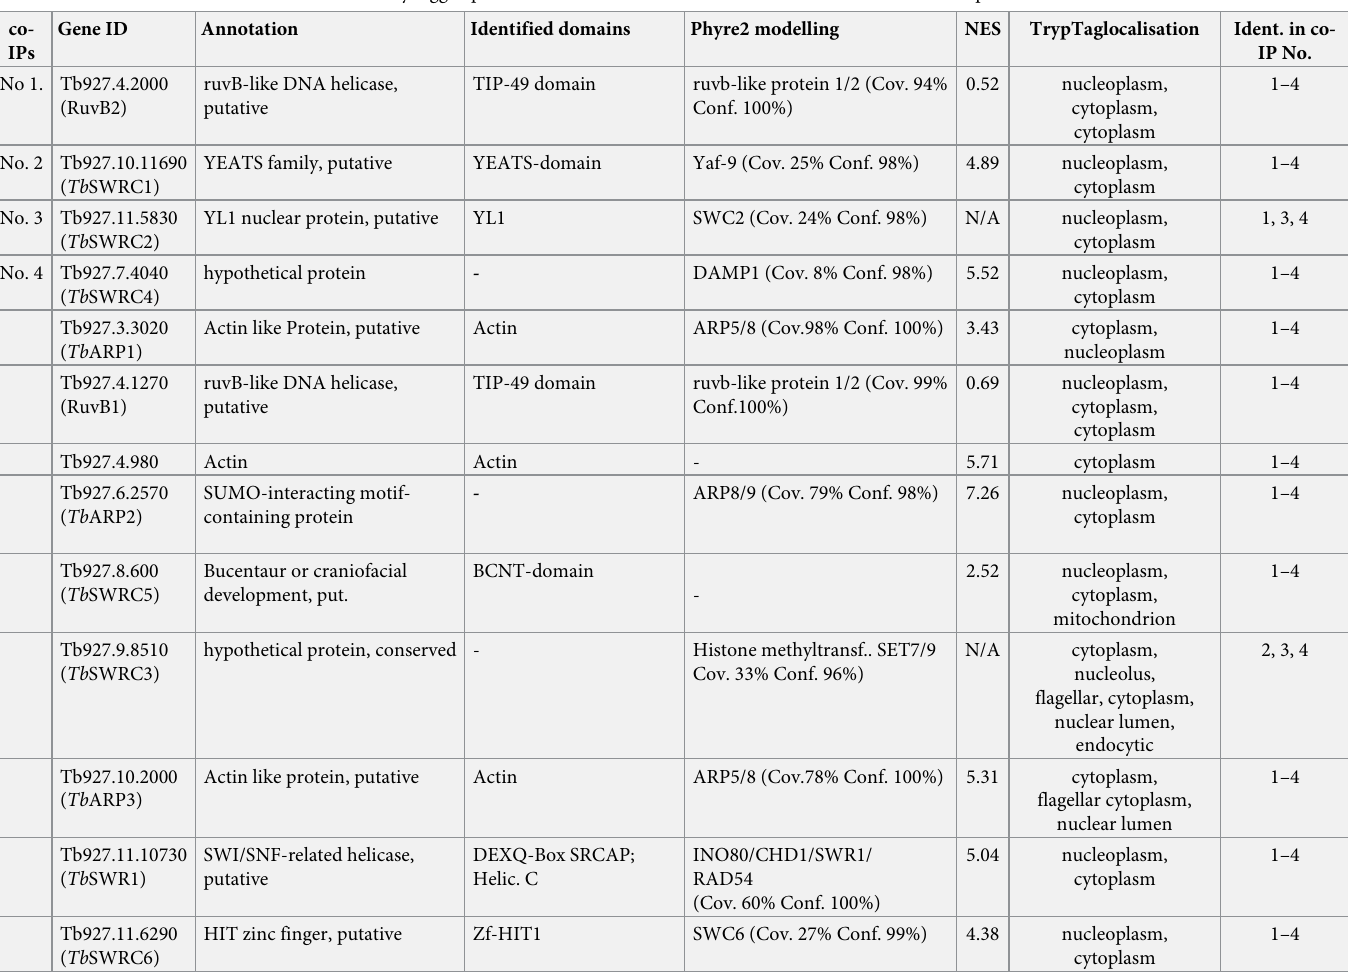
Table 2. Characterisation of the novel SWR1 complex components. 13 proteins with a positive or unknown NES were identified by MS analysis in at least three of the four co-IP experiments. The initial co-IP was performed with RuvB2 (Tb927.4.2000, the reciprocal co-IPs with the proteins Tb927.10.11690, Tb927.11.5830 and Tb927.7.4040 were performed to confirm the RuvB2 co-IP data). The “Annotation” column indicates the curated annotation that was found for the corresponding acces- sion number in the TriTryp database. The”identified domains” column displays the domains that were found by BLAST search using the NCBI database. The Phyre2 modelling column indicates proteins that were identified by homology modelling. Coverage (Cov.) indicates the coverage in percent between query and template. The con- fidence (Conf.) represents the relative probability in percent (from 0 to 100) that the match between query and template is a true homology. The nuclear enrichment score (NES; (52)) indicates the probability of a nuclear localisation based on cell fractionation combined with quantitative MS analysis. The column "TrypTag localisation” indi- cates the cellular localisation of N- and C-terminally tagged proteins. The last column shows in which of the four co-IPs the protein could be